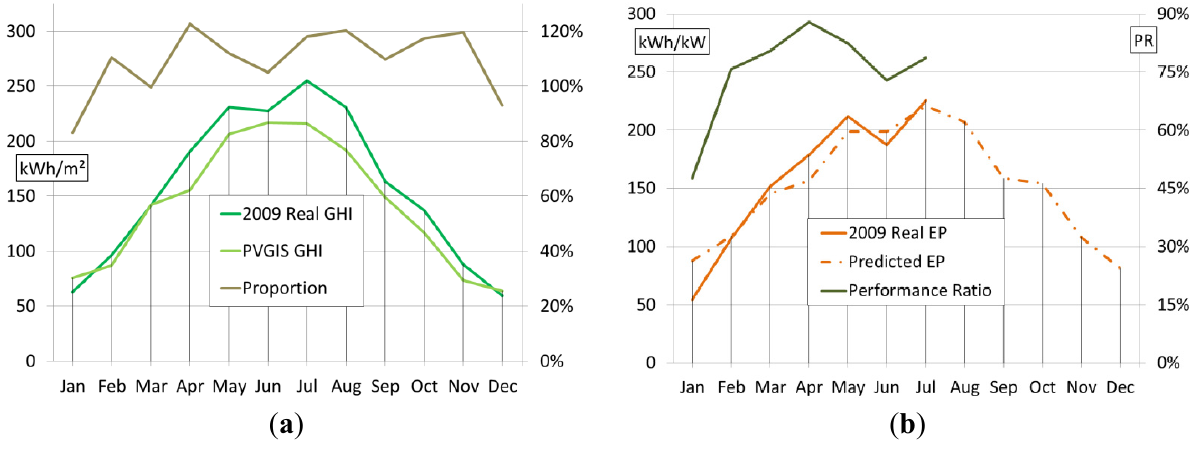
Figure 5. ( a ) Real GHI, PVGIS GHI, and real/PVGIS GHI in 2009; ( b ) Real EP, EP prediction based on constant PR, and estimated PR values for the Écija CPV installation in 2009.